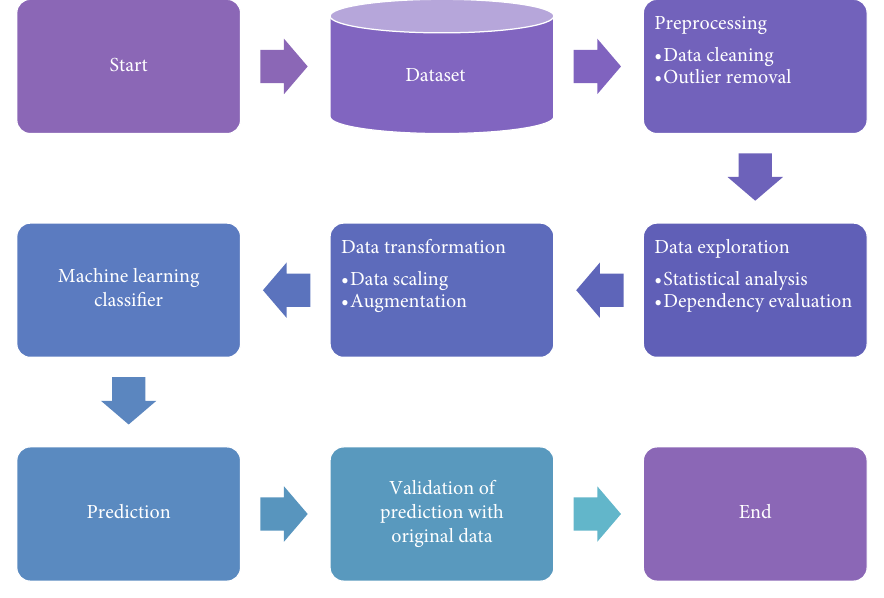
Figure 1: Proposed work fl